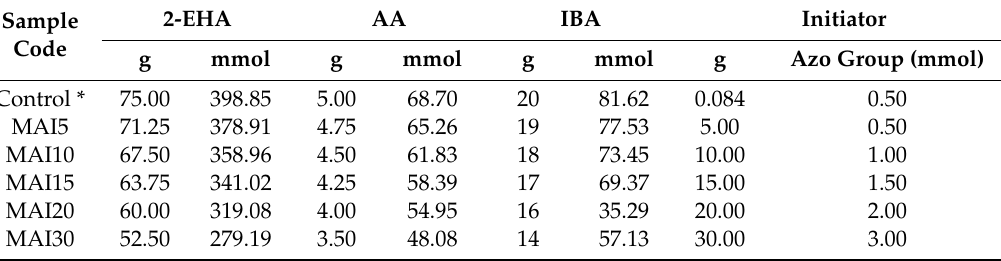
Table 1. Monomer composition of SPSA.